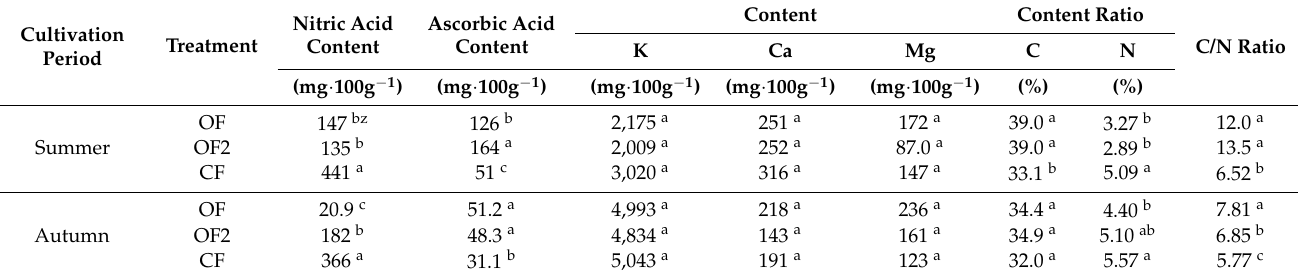
Table 3. The effect of different fertilization methods on the chemical composition of bok